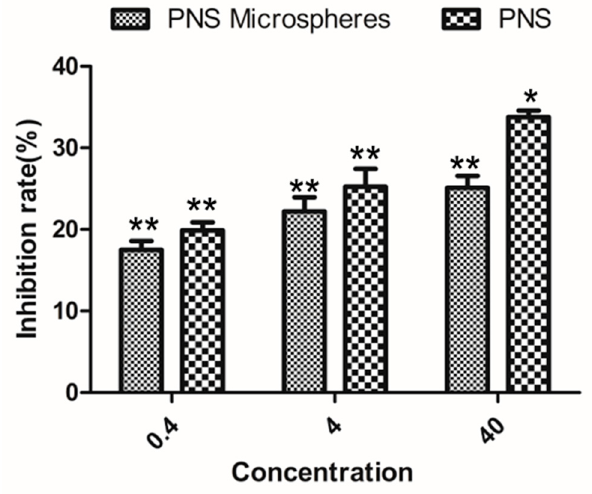
Figure 9. Antitumor activity of PNS and PNS microspheres. * P < 0.05 and ** P < 0.01 compared with control group. The control group was cells that grew in the same environment without drugs.